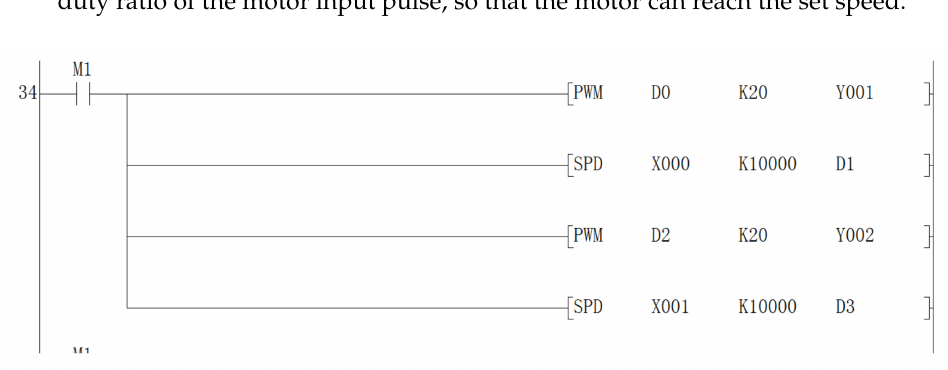
Figure A2. Cutter center distance initialization and change ladder diagram. (2) Cutter speed ladder diagram: responsible for monitoring the speed and adjusting the duty ratio of the motor input pulse, so that the motor can reach the set speed.